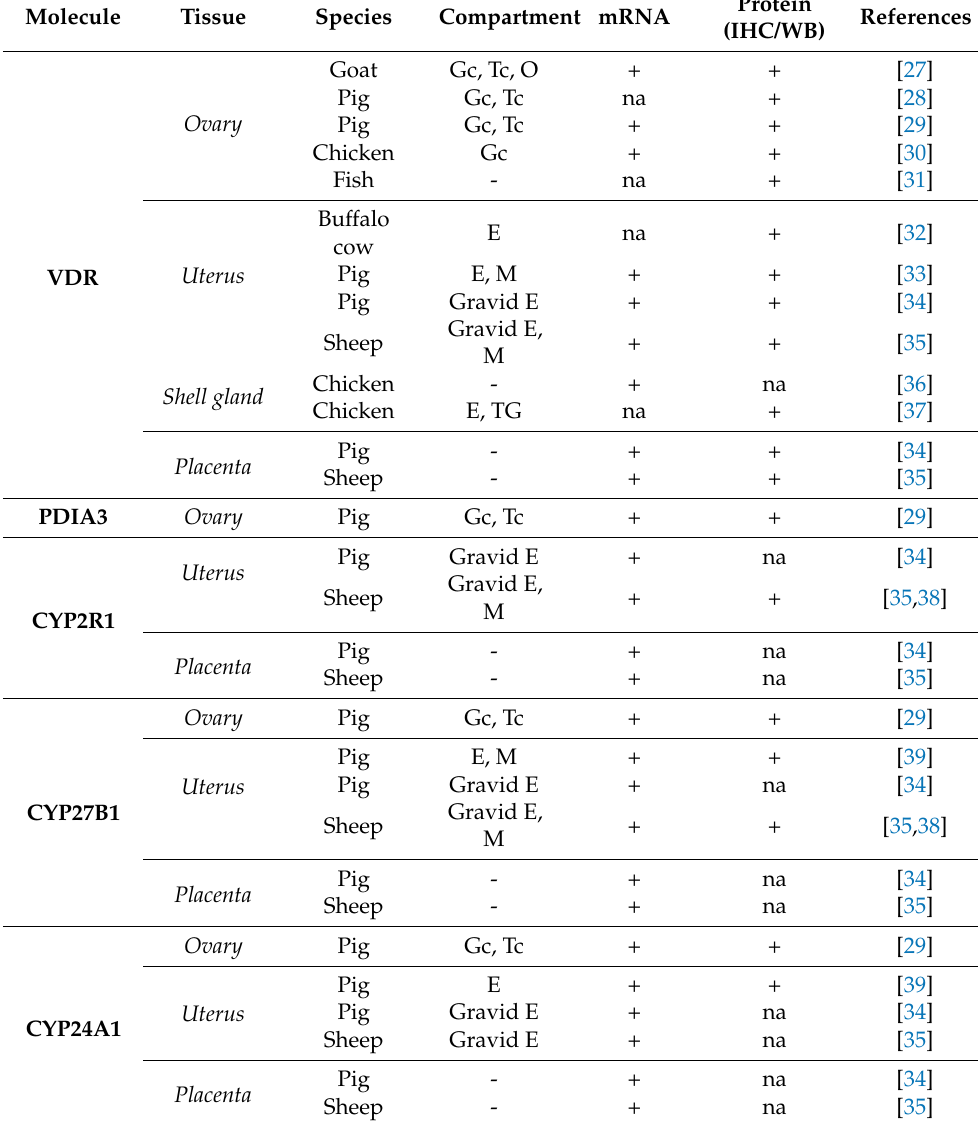
Table 1. Vitamin D 3 -related molecule expression in the female reproductive system of farm animals, birds and fish. Molecule Tissue